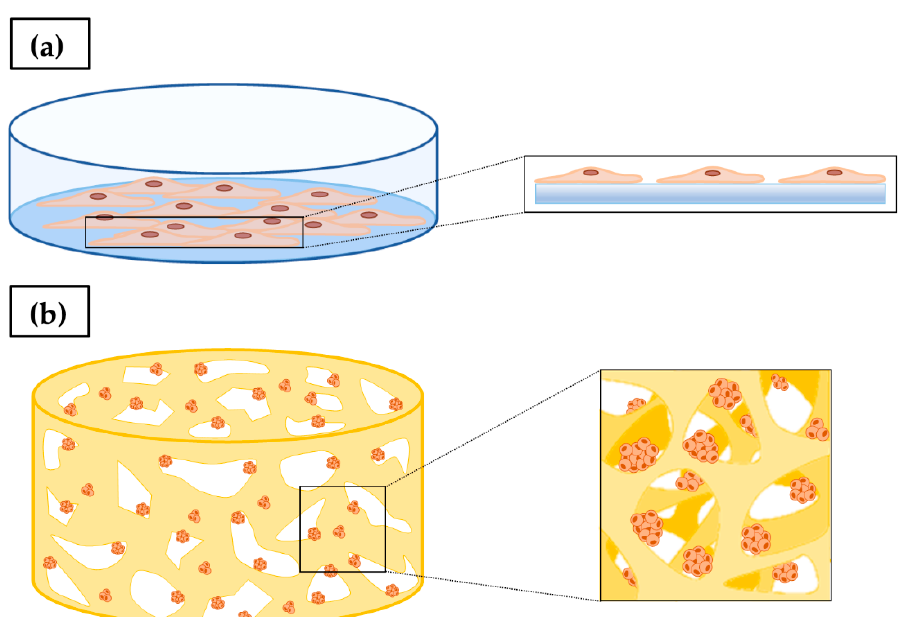
Figure 3. ( a ) Two-dimensional cell culture: cells cultured in a petri dish arranged to form a cellular monolayer with a flat cell shape that does not closely recapitulate the real physiological cell morphology. ( b ) 3D cell culture: in the 3D microenvironment, cells form multicellular aggregates, presenting a morphology and behavior more representative of in vivo systems.